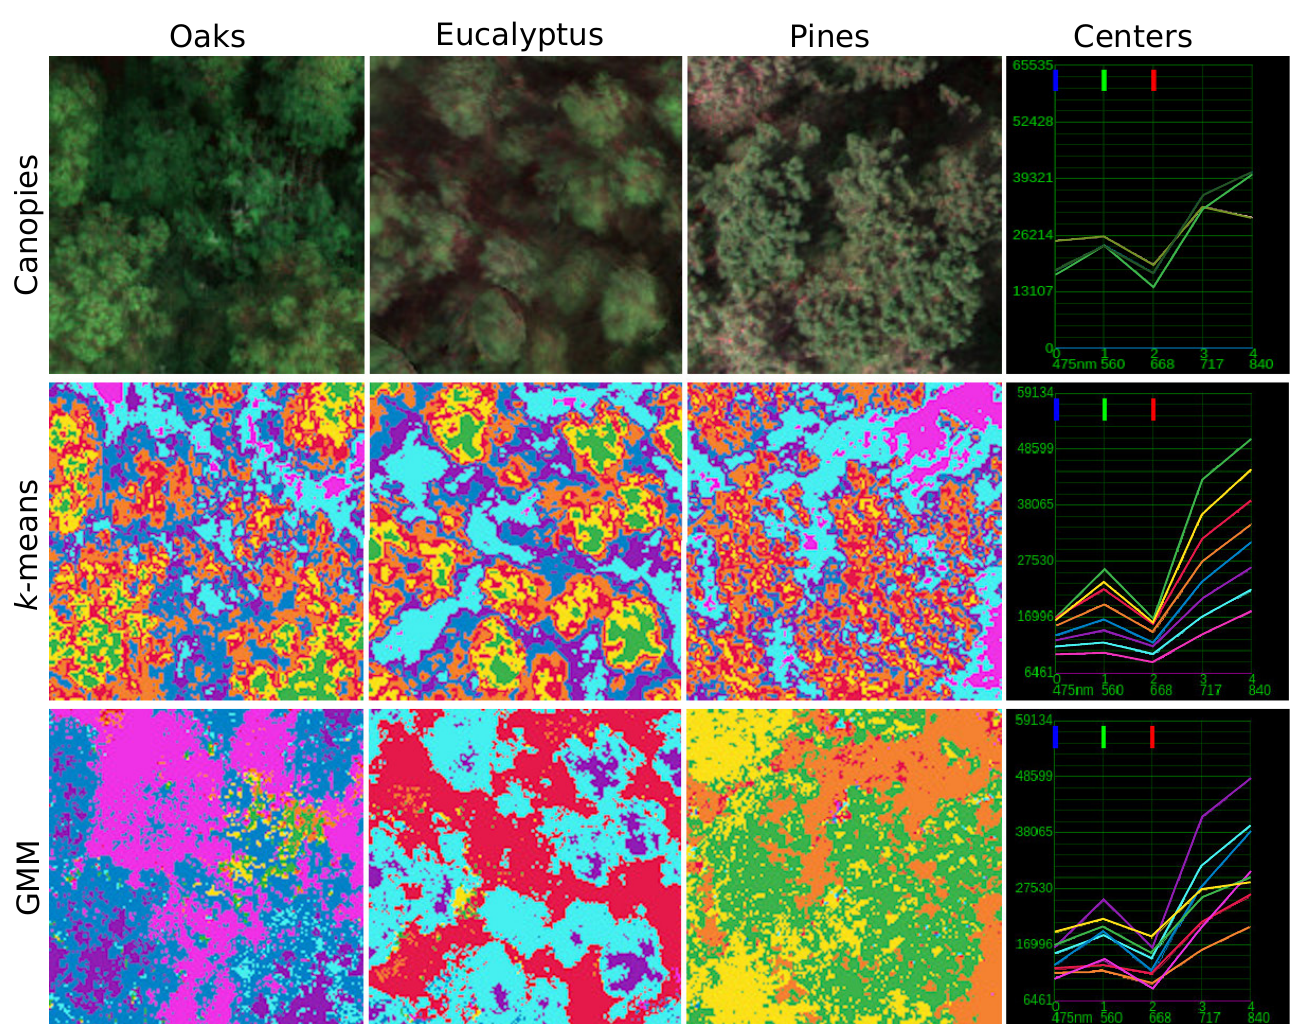
Figure 12. Examples of texture codebook generation. Top: oak, eucalyptus, and pine canopies, and mean of their spectral signatures. Middle: clusterization and spectral signatures of the centers using k means with eight classes. Bottom: clusterization and spectral signatures of the centers using GMM with eight